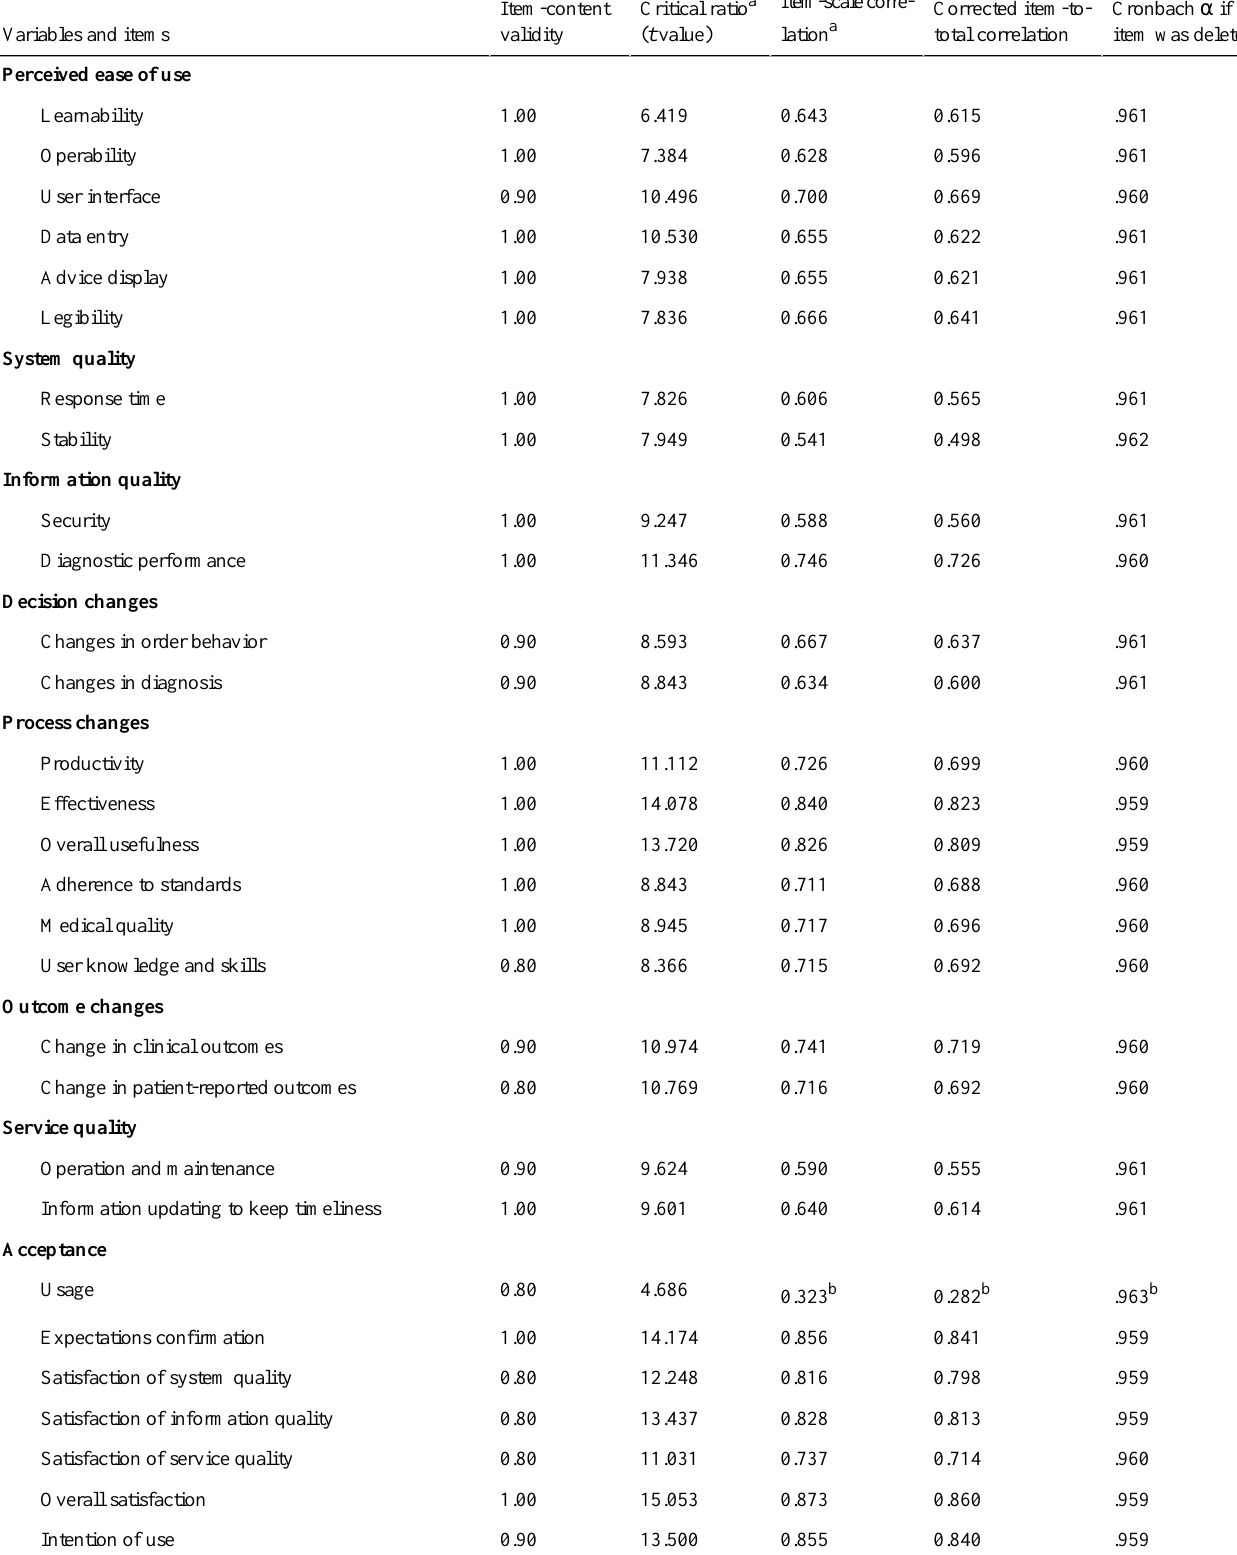
Table 1. Accepted items in the Delphi